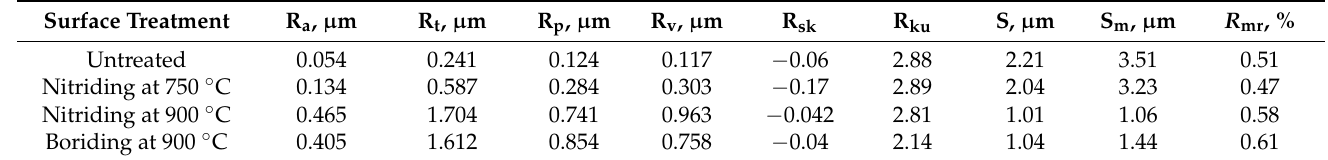
Table 3. Parameters of surface roughness of titanium Grade 2 after surface treatment.